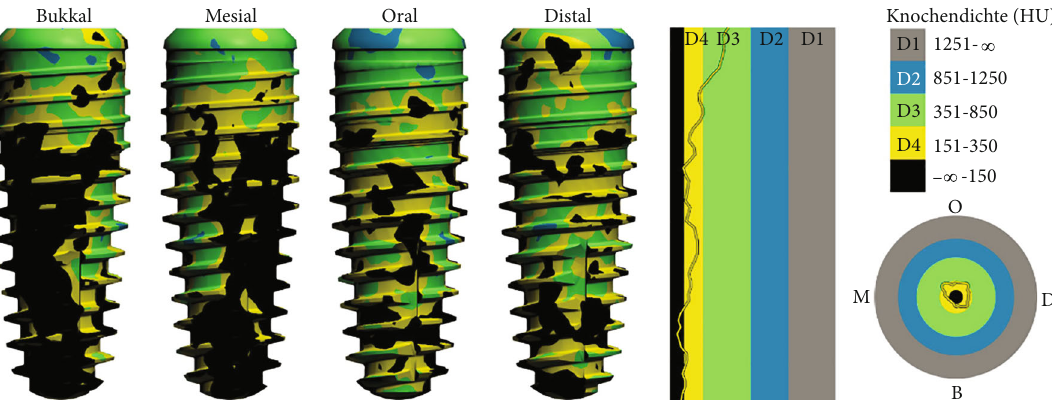
Figure 6: Simulation with conical implant